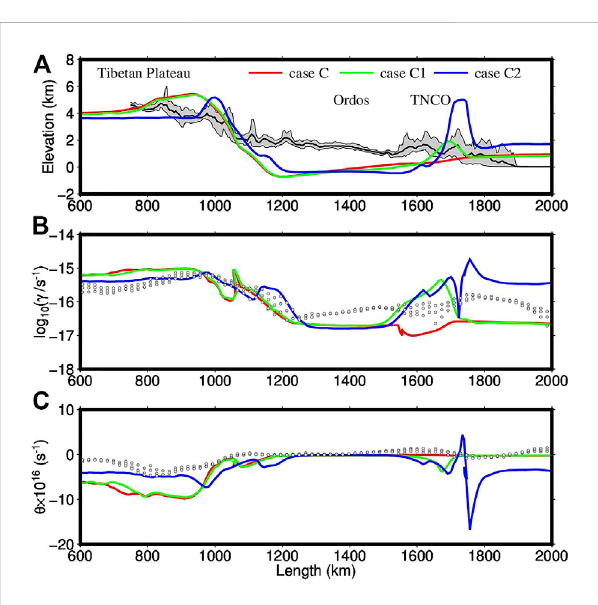
FIGURE 9 Comparisons of the numerical models (cases C, C1, C2) with the observed surface topography (A) , the maximum shear strain rate (B) , andthedilatationstrainrate (C) acrossthenortheasternmarginsofthe Tibetan Plateau (CC ’ pro fi le inFigure 1D),respectively. Grayareas in (A) indicate the observed topographic change. Gray dots in (B – C) indicate the observed strain rates. The data of topography and strain rate are consistent with those shown in Figure